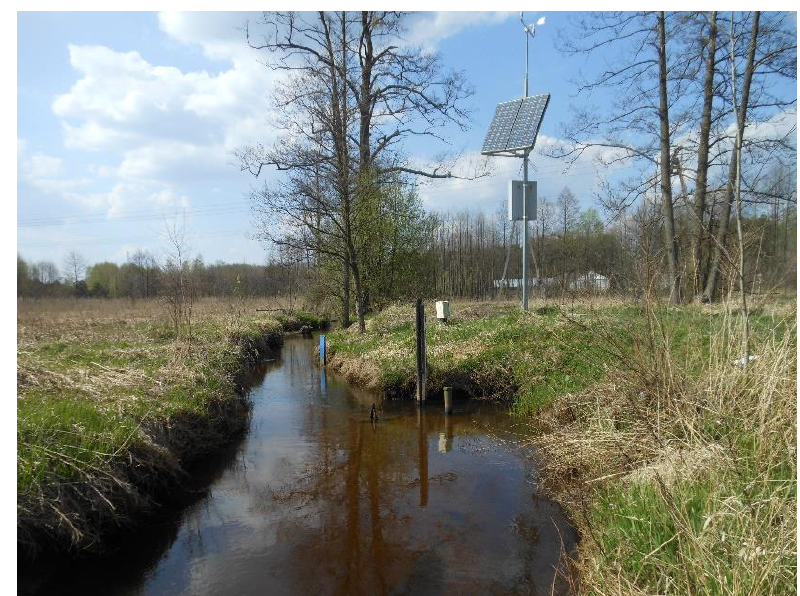
Figure 2. View of the gauging station at Płachty Stare (photo is looking downstream during an average flow period in April 2015).